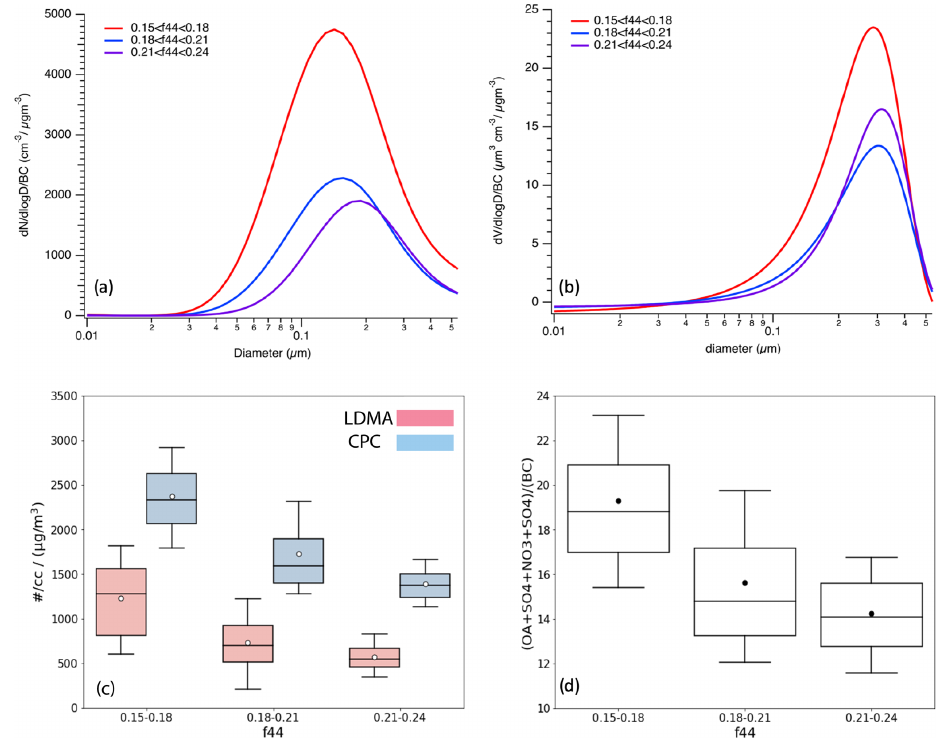
Figure 14. (a) The 24 September 2016 LDMA-derived number particle size distribution for three f 44 bins (0.15–0.18 – red; 0.18–0.21 – blue; 0.21–0.24 – purple), divided by the BC mass. Panel (b) is the same as (a) but for the LDMA-derived particle size distribution. Panel (c) shows the LDMA and CPC particle number concentration as a function of f 44 and the (d) ratio of non-BC total mass (OA + SO 4 + NO 3 + NH 4 ) to BC as a function of the three f 44 bins. All data are selected from OA > 20µgm − 3